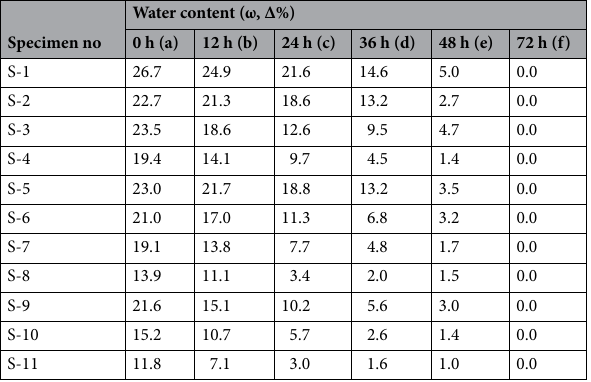
Table 3. Water contents of specimens according to drying time. Drying times are as indicated, varying between 0 and 72 h, with specimen sets being denoted by (a) to (f), respectively. As the water content (ω) at each drying interval was calculated from the specimen dried for 72 h, water contents were expressed as the difference (Δ%) with the water content of that specimen.